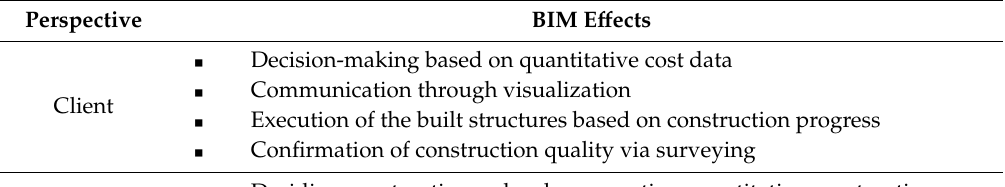
Figure 10. Web and app-based operational samples using the proposed system. Table 11. Expected effects of application of the BIM-based construction management system.